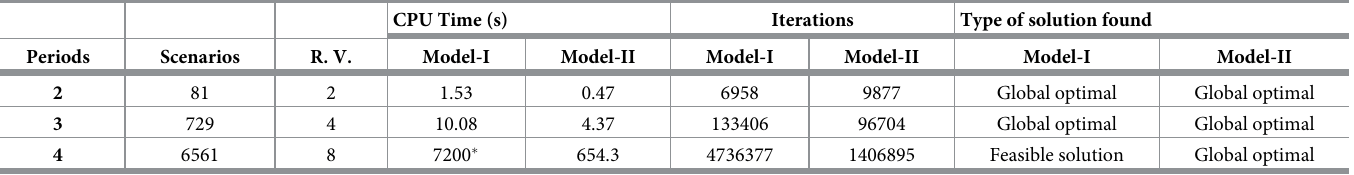
Table 6. Comparison between Model-I and Model-II regarding the time it takes to solve the problem and the number of iterations. Own elaboration. CPU Time (s) Iterations Type of solution found Periods